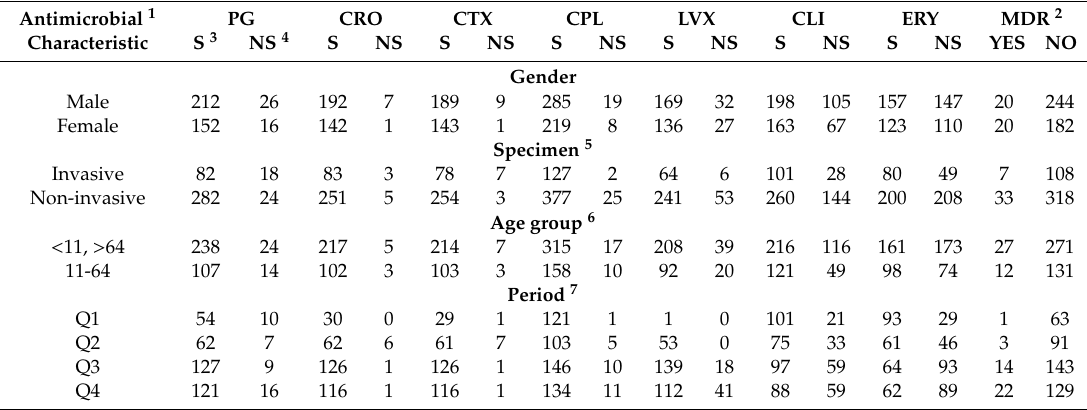
Table 2. Antimicrobial susceptibility testing (AST) results among unique Streptococcus pneumoniae isolates at Jordan University Hospital